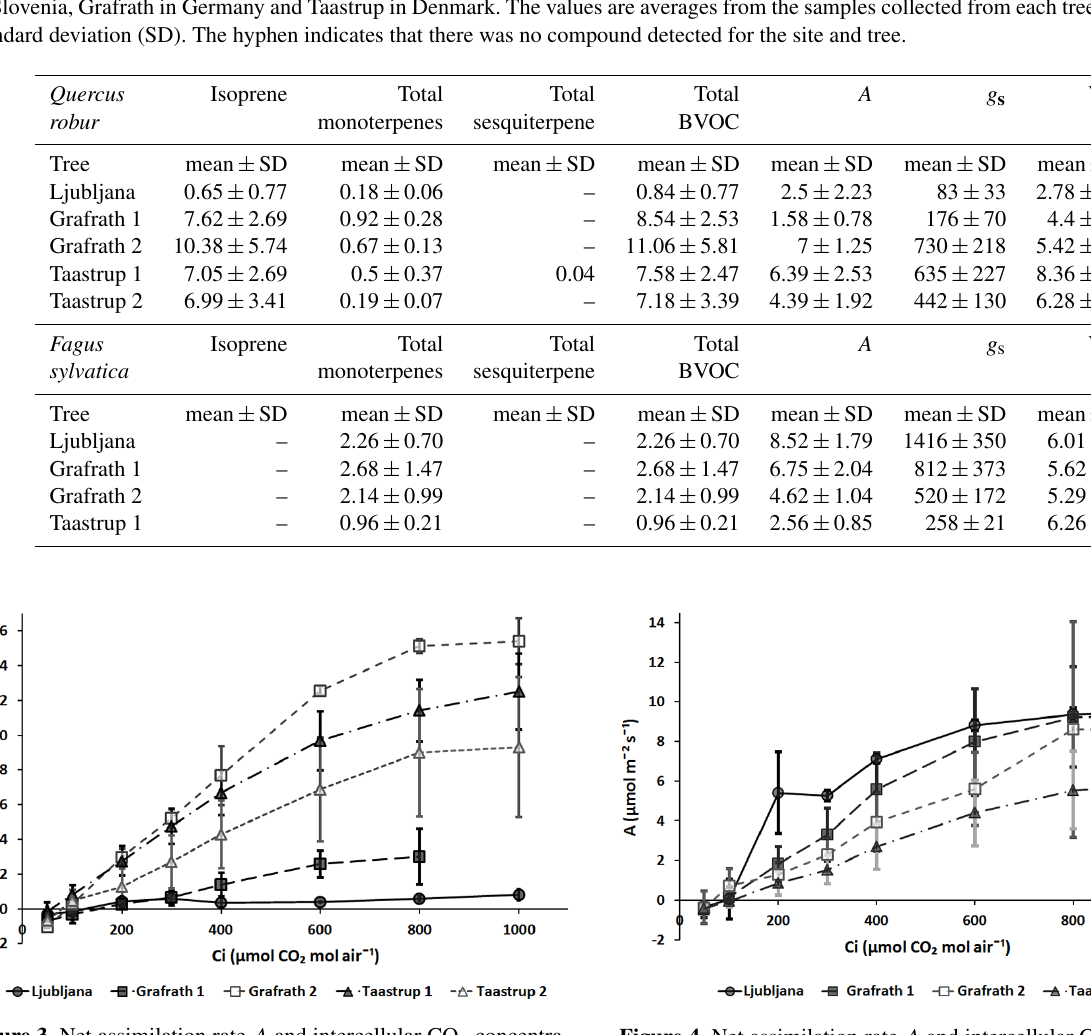
Table 3. Standardized BVOC emission (µggdw − 1 h − 1 ) , the net assimilation rate ( A , µmol CO 2 m − 2 s − 1 ) , stomatal conductance ( g s ,mmol